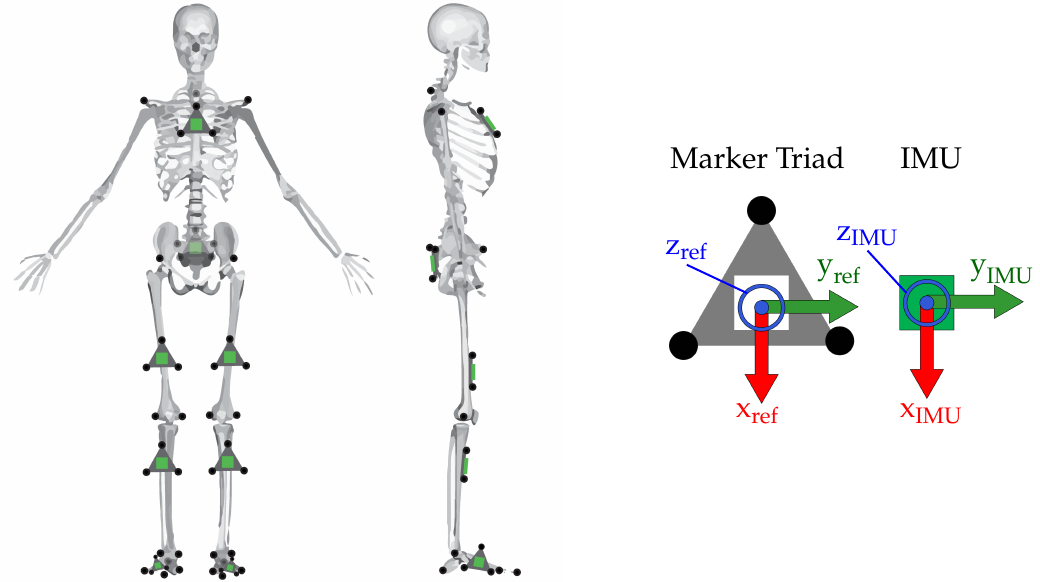
Figure 4. ( Left ) Placement of the reflective markers (black circles) and IMUs (green squares) on the subject. IMUs on the thigh and shank were not placed precisely, and location varied both vertically and in the transverse plane. ( Right ) A blown-up illustration of the marker triads with three markers affixed and IMU. Coordinate system of the IMU was known a priori, and the comparison reference coordinate system of the marker triad was constructed to